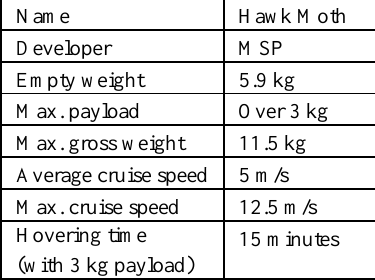
Table 1. Selected parameters of the Hawk Moth platform